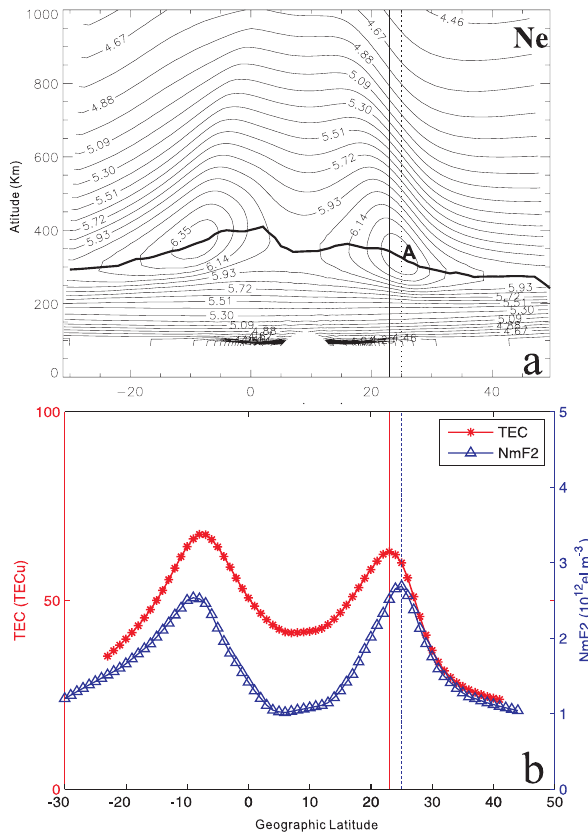
Fig. 11. (a) Distribution of the electron density derived from the Sami2 Model at 15:00LT, 1 October 2004 (unit: log(Ne)cm − 3 ). (b) Distribution of TEC and Nm F2 based on the simulative data of Sami2 Model at 15:00LT, 1 October